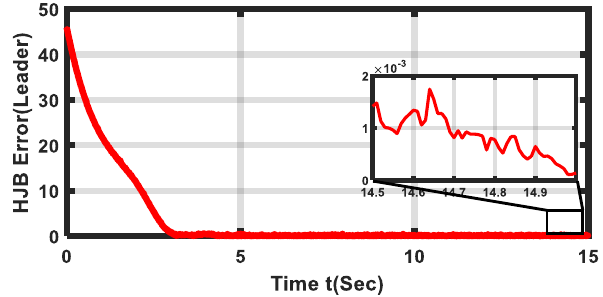
Figure 6. HJB equation error of the leader in group 1.